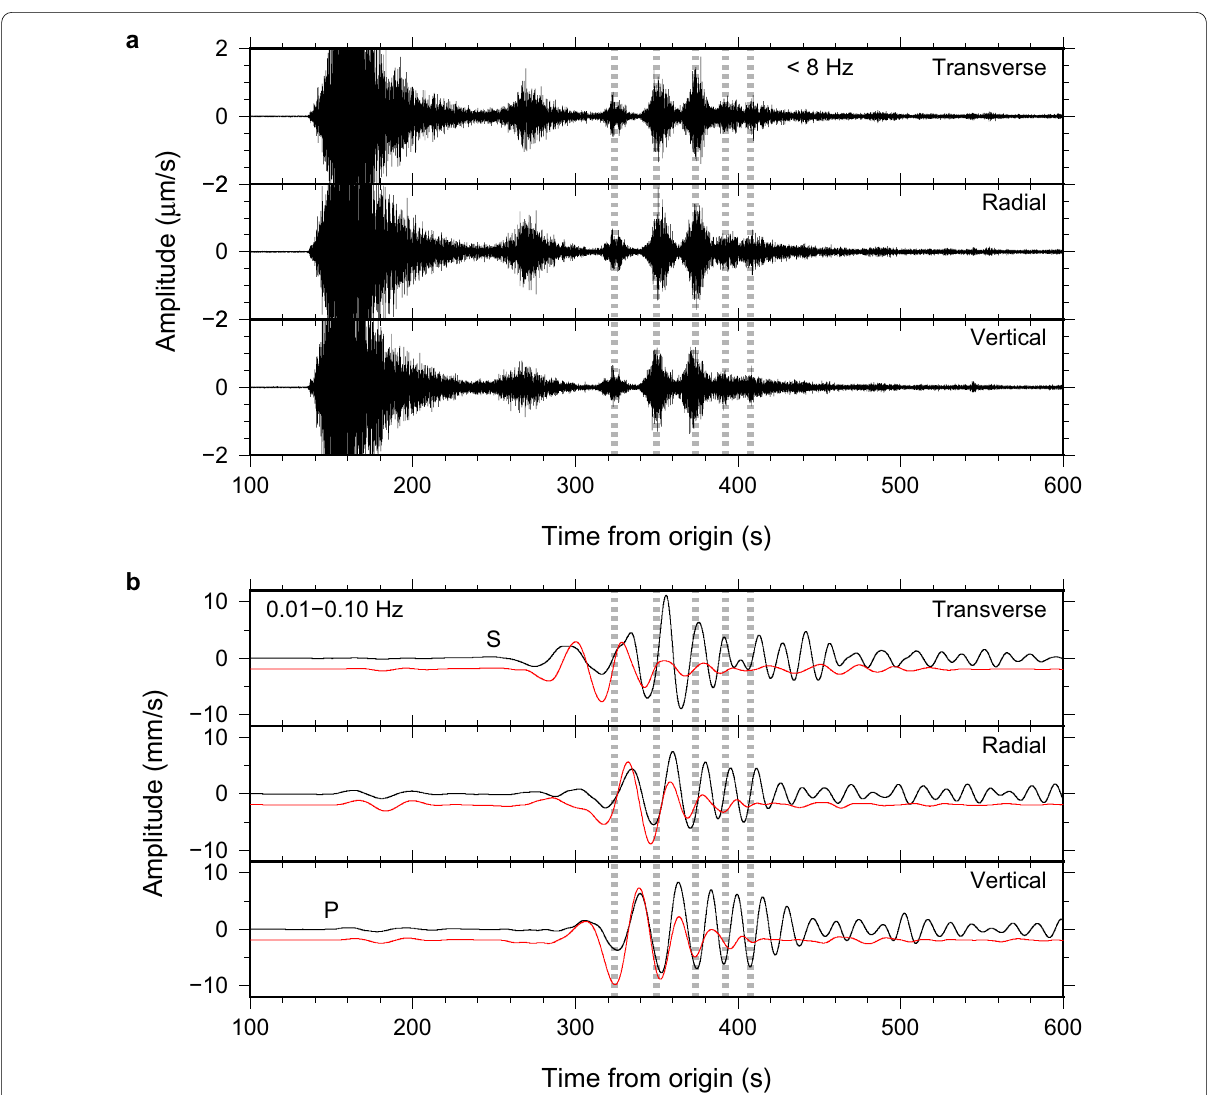
Fig. 2 Velocity waveforms for the Mw8.2 Tehuantepec earthquake of September 8, 2017 (UT). a Waveforms representing the transverse, radial, and vertical components, high-pass filtered at 8 Hz, recorded at the National Seismological Service (SSN) of Mexico station CJIG (Fig. 1). b Waveforms representing the transverse, radial, and vertical components, bandpass filtered between 0.01 and 0.10 Hz. Recorded waveforms are in black, and simulated waveforms are in red. The vertical dashed lines in gray correspond to the large peaks of triggered